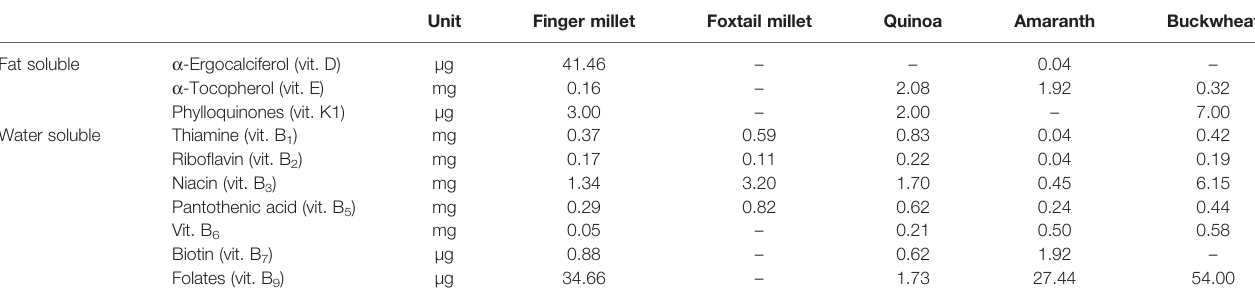
TABLE 4 | Vitamins in minor millets and